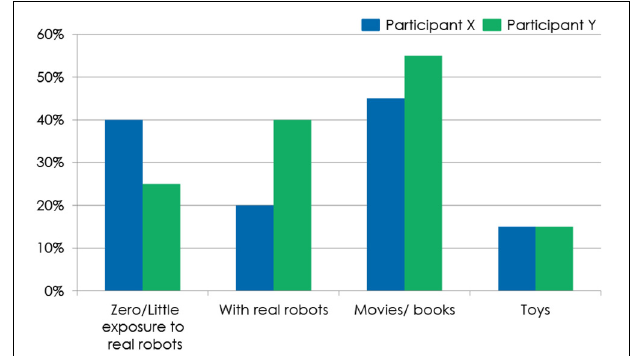
FIGURE 5 | The participants’ experience of the familiar at the different key-moments of the interaction with the robot: in the beginning of the interaction, when taking the envelope from the robot, at the end of the interaction, and all along the entire interaction.